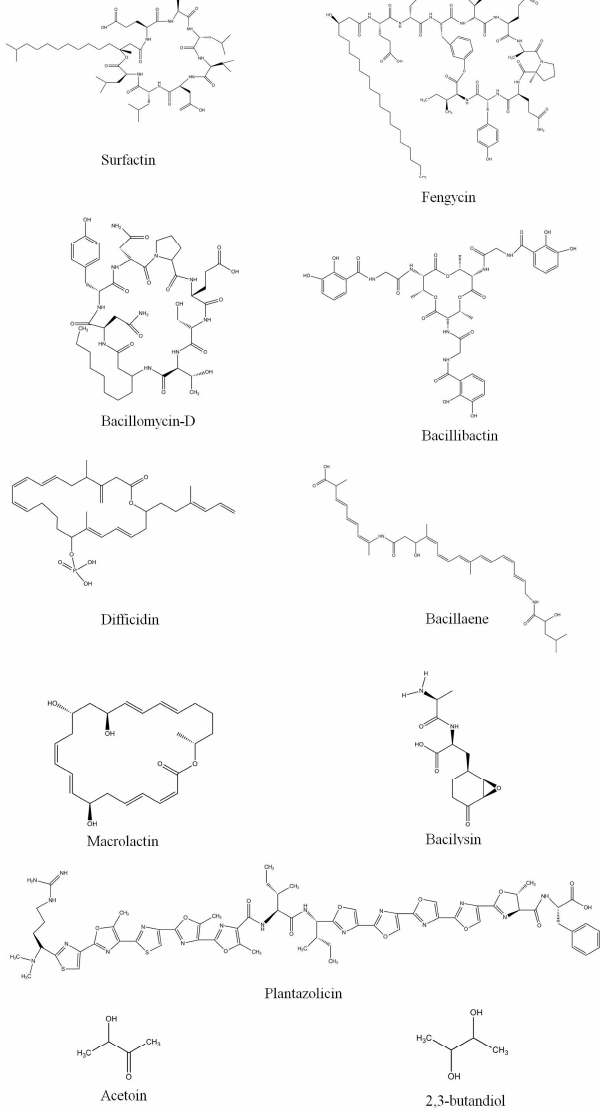
Figure 3. Molecular structure of ribosomal and nonribosomal bioactive compounds synthesized by B. velezensis .